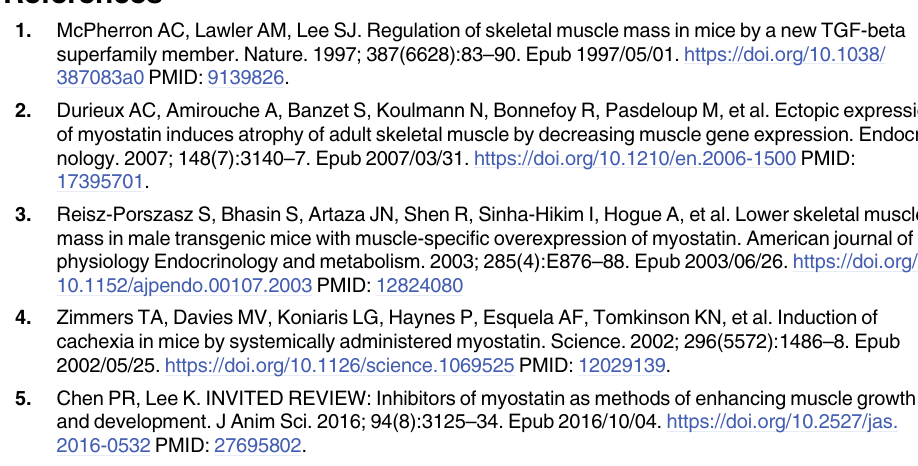
S1 Table. Primers used for pMALc5x expression vector construction of truncated MSTN1 propeptides. Underline indicates EcoRI; site used in the construction of expression vectors. (PDF) S1 Fig. SDS-PAGE analysis of MBP-Pro45-70-His6 purified with two-step chromatogra- phy. Ni-NTA agarose affinity chromatography was first used, followed by amylose resin affin- ity chromatography for purification. Proteins were visualized with Coomassie blue staining. M, protein ladder; T , total protein; S , soluble fraction; P : pellet (insoluble fraction), FT1 : flow- through fraction of Ni-NTA agarose, W1 : washing fraction of Ni-NTA agarose, E1 : elution fraction of Ni-NTA agarose, FT2 : flow-through fraction of amylose resin, W2 : washing frac- tion of amylose resin, E2 : elution fraction of amylose resin. (TIF) S2 Fig. Titer values after the administration of Pro45-65-NH2. 1000-fold diluted sera were used for titer measurement. Open circle ( � ) and closed square ( ■ ) indicate 0 and 20 mg/kg body wt administration of Pro45-65-NH2, respectively. Student‘s t-test was used to compare the mean difference.